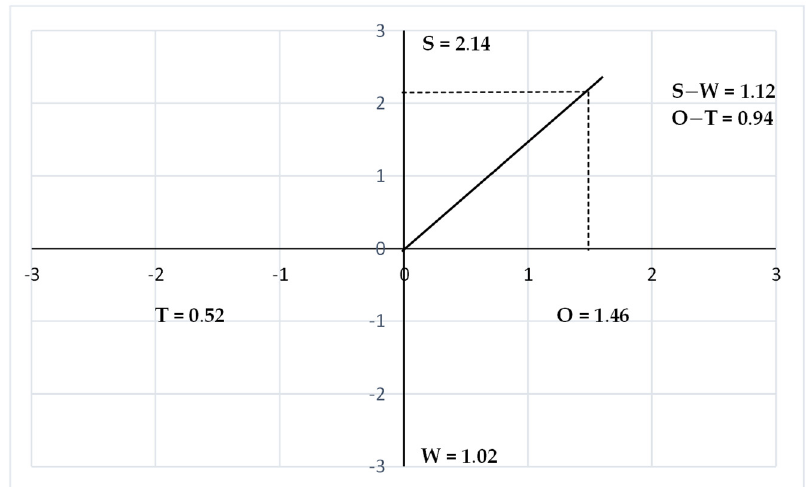
Figure 4. Map of the strength of sorghum development in Wonogiri Central Java,